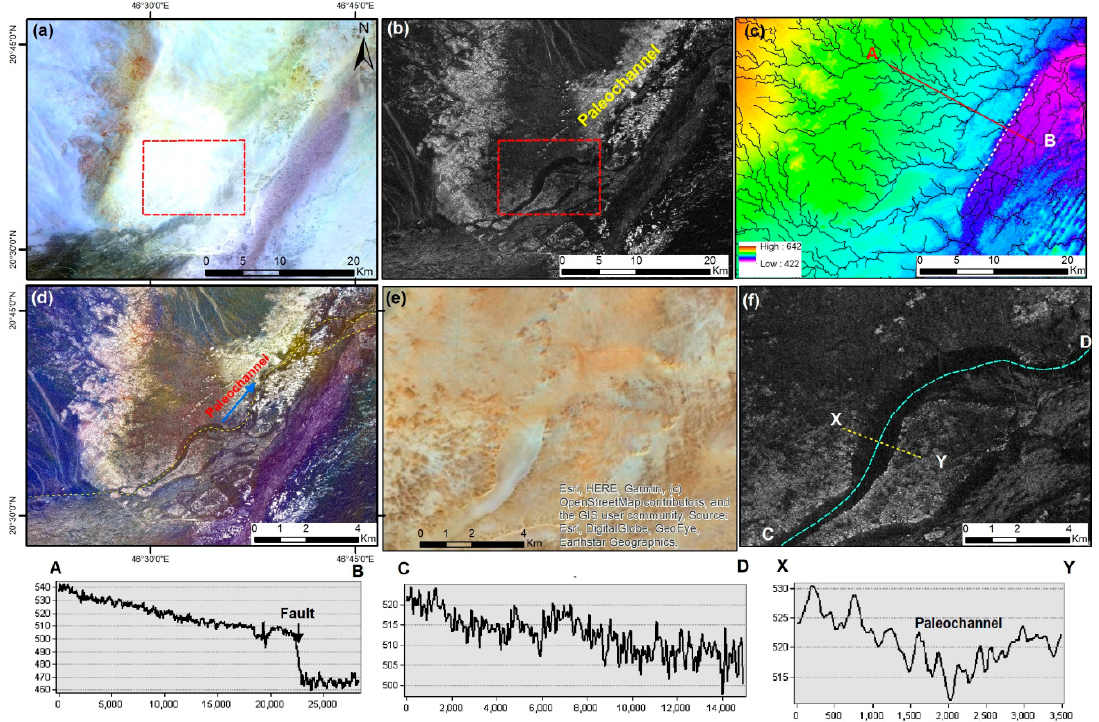
Figure 2. ( a ) Landsat-8 OLI data indicate a paleochannel obscured by aeolian deposits, at Al Salayel and Wadi ad ‐ Dawasir. Evidence of a paleochannel is difficult to observe in this image; the portion of the image enclosed by the red box has been magnified and is indicated within Figure 2e,f. ( b ) The ALOS/PALSAR image for the area indicated in Figure 2a; the paleochannel is clearly shown. ( c ) A SRTM DEM (with a resolution of 30 m) for the area in Figure 2a, displaying the topographic distribution, the extracted stream networks that extend in a northeast direction, and the location of the fault via the white dashed line. ( d ) The paleochannel, manually digitized from ALOS/PALSAR data, shown with a yellow dashed line, overlaid on the combined ALOS/PALSAR and Landsat OLI data for the area in Figure 2a. ( e ) A subset of Esri Digital Globe/Geo ‐ Eye, displayed by the red box in Figure 2a, has difficulty displaying the edges of paleochannel that are clearly marked by sand. The ALOS/PALSAR subset in ( f ) displays the channel geometry in black tones, although the area is difficult to discern through optical data. The transverse profile A–B runs across the paleochannel; the longitudinal profile C ‐ D runs along the detected paleochannel and displays a general slope towards the northeast. The transverse profile X–Y extends across the paleochannel, indicating its structure in detail.